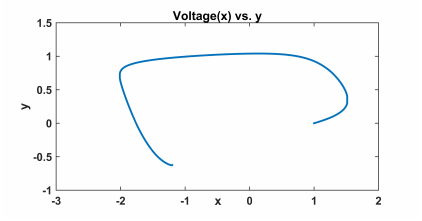
Figure 5. Responses of membrane poten- tial without an external current I(t) = 0 µ A / cm 2 , a = 0.8 , b = 0.7 & c = 3